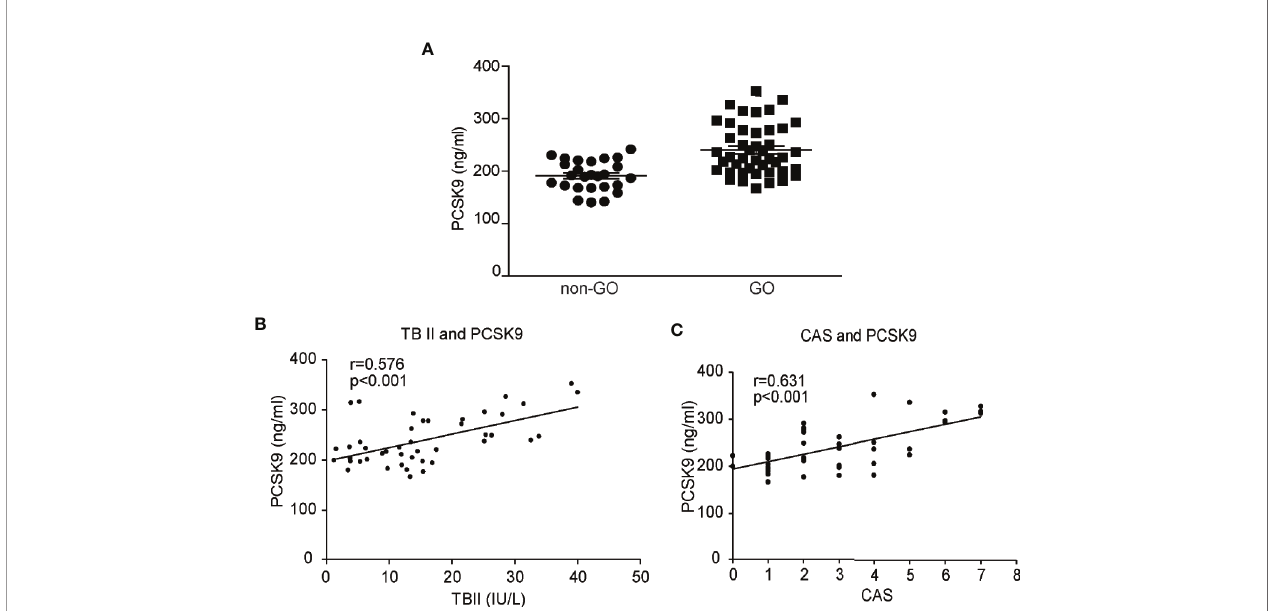
FIGURE 6 | Comparison of plasma levels of proprotein convertase subtilisin/kexin type 9 (PCSK9) between Graves ’ orbitopathy (GO) patients and non-GO subjects, and correlation analyses between plasma levels of PCSK9, thyrotropin-binding inhibitor immunoglobulin and clinical activity score (CAS). The plasma levels of PCSK9 were measured in GO patients and non-GO subjects using ELISA. The samples were assayed in triplicate. (A) The mean PCSK9 plasma level was signi fi cantly higher in the GO patients (n=44, 239.97 ± 48.20 ng/ml) than the healthy subjects (n=26, 190.83 ± 28.77 ng/ml; p < 0.01). A single dot represents the value obtained from a single donor. The results of Spearman ’ s rank correlation test between plasma levels of PCSK9 (GO patients, n=44) and (B) plasma levels of thyrotropin binding inhibitory immunoglobulin (TBII) (GO patients, n=44) or (C) clinical activity score (CAS) (GO patients, n=44) are shown. The plasma PCSK9 concentrations showed signi fi cant associations with the plasma TBII levels (r = 0.576, p < 0.001) and CAS (r = 0.631, p <